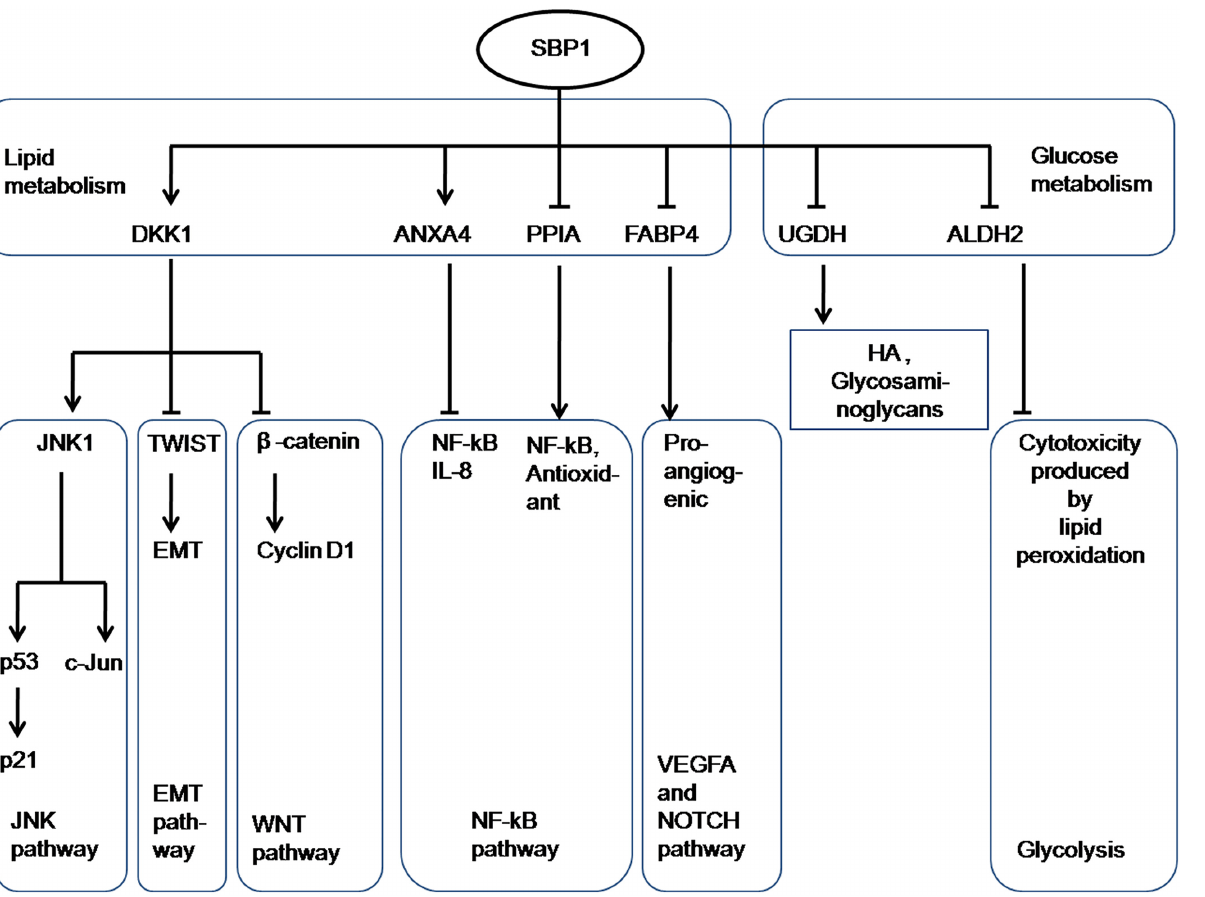
Fig 5. Hypothetic pathways of SBP1-mediated anti-cancer functions in vivo . SBP1-mediated anti-cancer effects may be through lipid/glucose metabolism. The possible functional regulation between SBP1 and related proteins is illustrated.